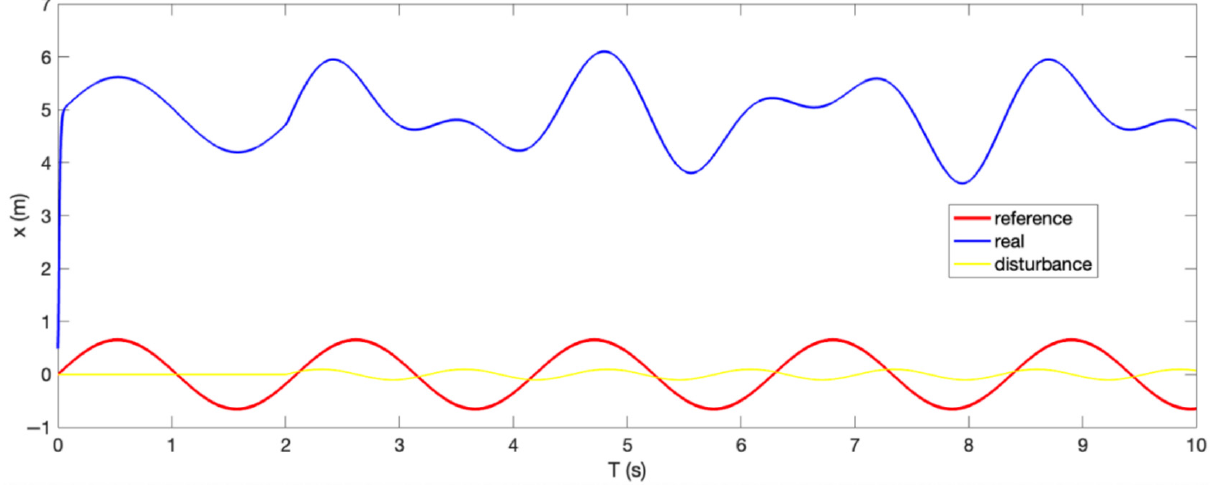
Figure 19. The reference trajectory (red cure) and the system response (blue curve) of the footrest posture control without RBFNN approximation with disturbance (yellow curve).